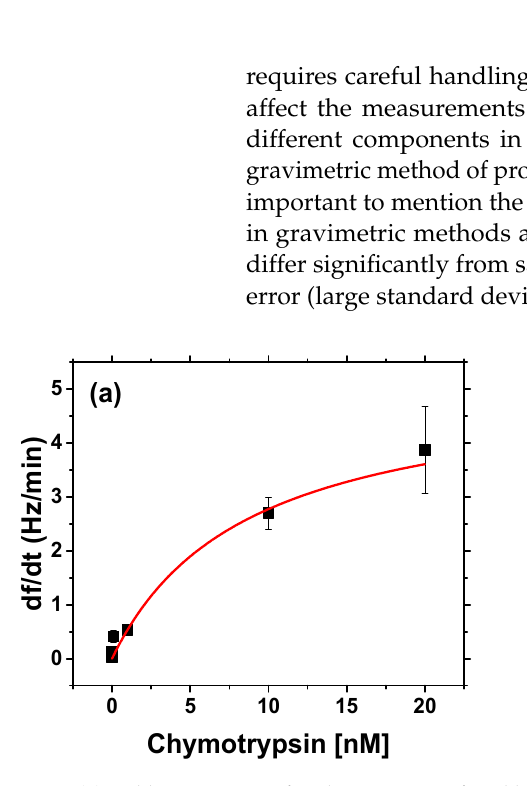
Figure 11. ( a ) Calibration curve for chymotrypsin fitted by reverse Michaelis—Menten model, v = df/dt was the first derivation of frequency obtained from kinetic curve. ( b ) Calibration curve: changes in frequency ∆ f = ( ∆ f chymo )/( ∆ f casein ) × 100 where ∆ f chymo = f − f 0 (where f is steady state frequency following addition of chymotrypsin and washing the surface by PBS and f 0 those prior addition of chymotrypsin) is change in frequency after chymotrypsin cleavage and ∆ f casein is frequency change after formation of β -casein layer. vs. lower chymotrypsin concentration range for determination of LOD. ( ∆ f = 5.17%nM − 1 c + 9.94%, R 2 = 0.84, where c is the concentration of chymotrypsin). The results represent mean ± SD obtained from 3 independent measurements at each concentration of chymotrypsin.